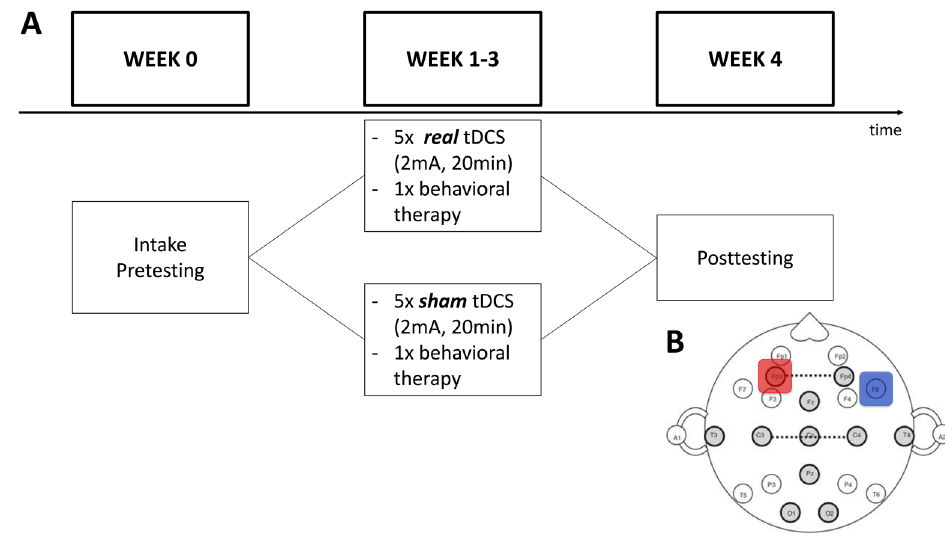
Figure 2. A . Visualization of the protocol, and B . electrode placement of the tDCS